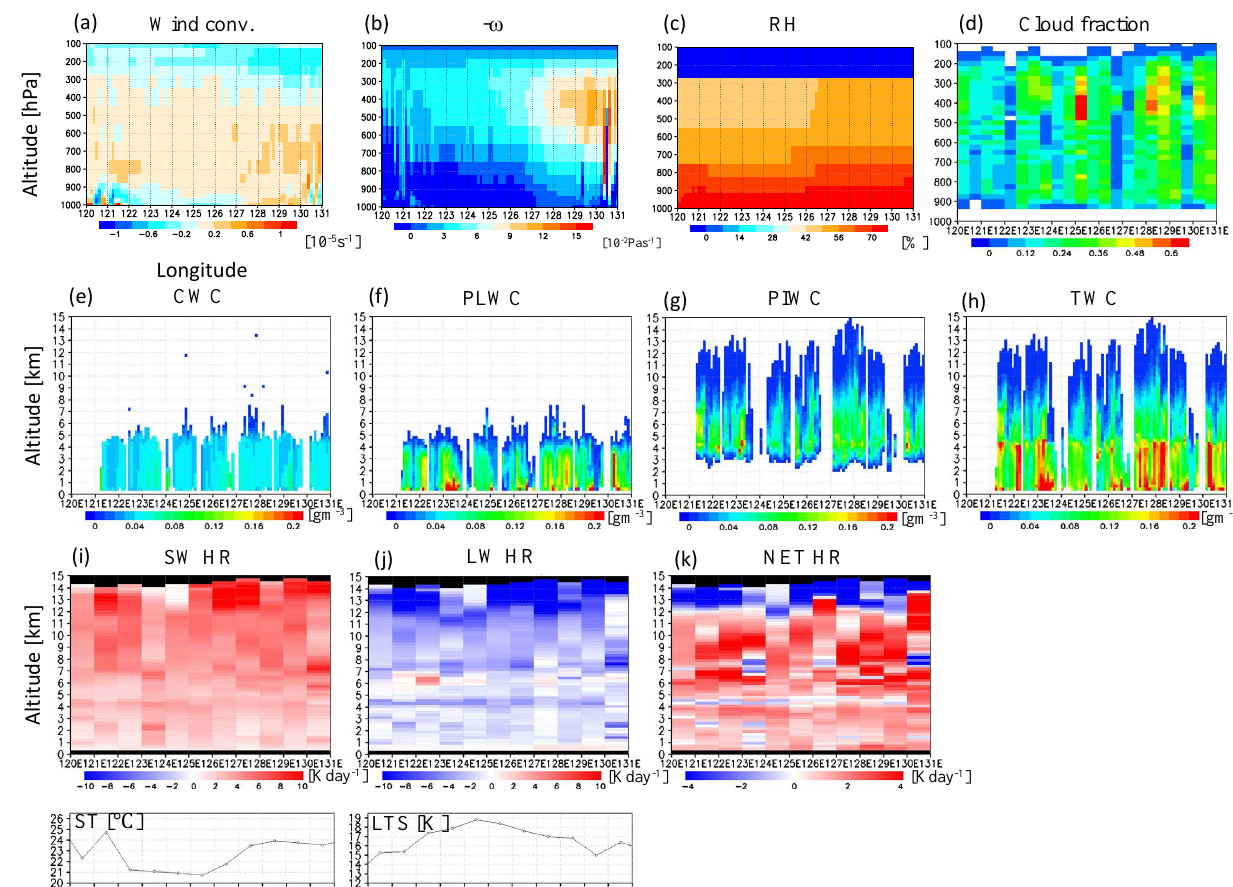
Figure 4. The meridional vertical sections in the thick dotted square (28–31.5 ◦ N, 120–131 ◦ E) of Fig. 1a. (a) Mean wind convergence (divergence) at 1000hPa (10 − 5 s − 1 ), (b) upward pressure velocity at 400hPa: − ω (10 − 2 Pas − 1 ), (c) relative humidity at 400hPa (%) for the target period from the Japan Meteorological Agency’s mesoscale model (MSM). (d) Mean cloud fraction, (e) cloud water content (gm − 3 ), (f) precipitating liquid water content (gm − 3 ), (g) precipitating ice water content (gm − 3 ), (h) total water content (gm − 3 ), (i) shortwave cloud radiative heating rate (K day − 1 , upper panel) and skin temperature ( ◦ C, lower panel), (j) longwave cloud radiative heating rate (K day − 1 , upper panel) and lower-tropospheric stability (K, lower panel), and (k) net (SW + LW) cloud radiative heating rate (K day − 1 ) using CloudSat